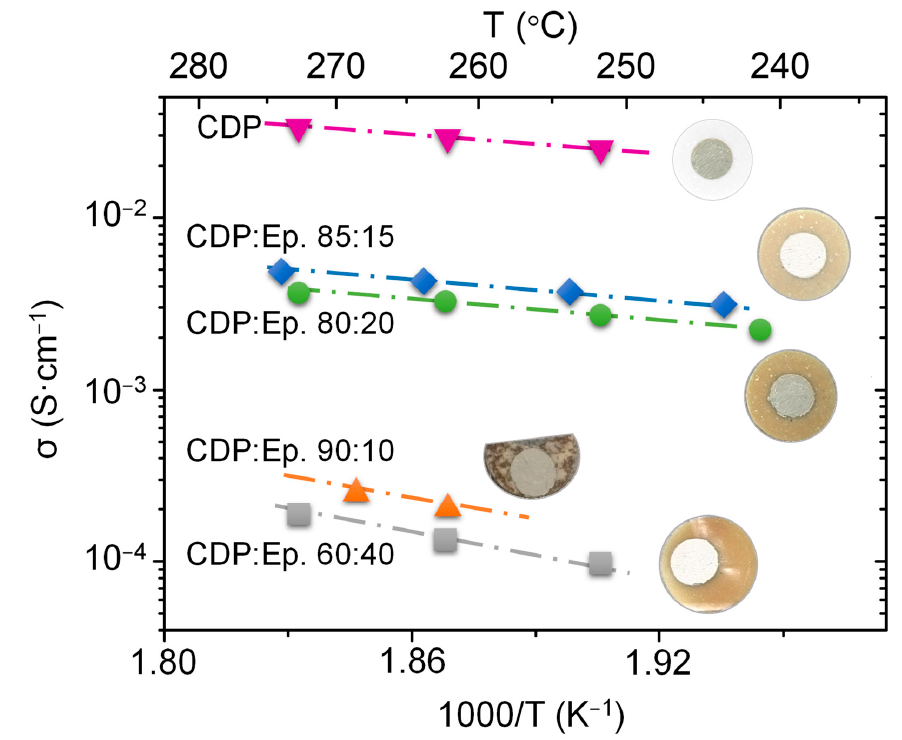
Figure 3. CDP: Conductivity of CDP composites extracted from electrochemical impedance spectroscopy measurements, measured in Argon with a 30% vol. of steam. Inset of samples after electrochemical test.